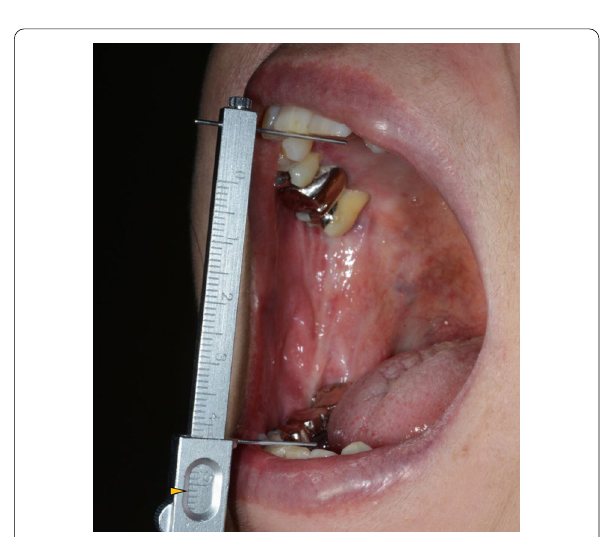
Fig. 9 Following mouth opening training, the maximum mouth opening distance improved to > 50 mm